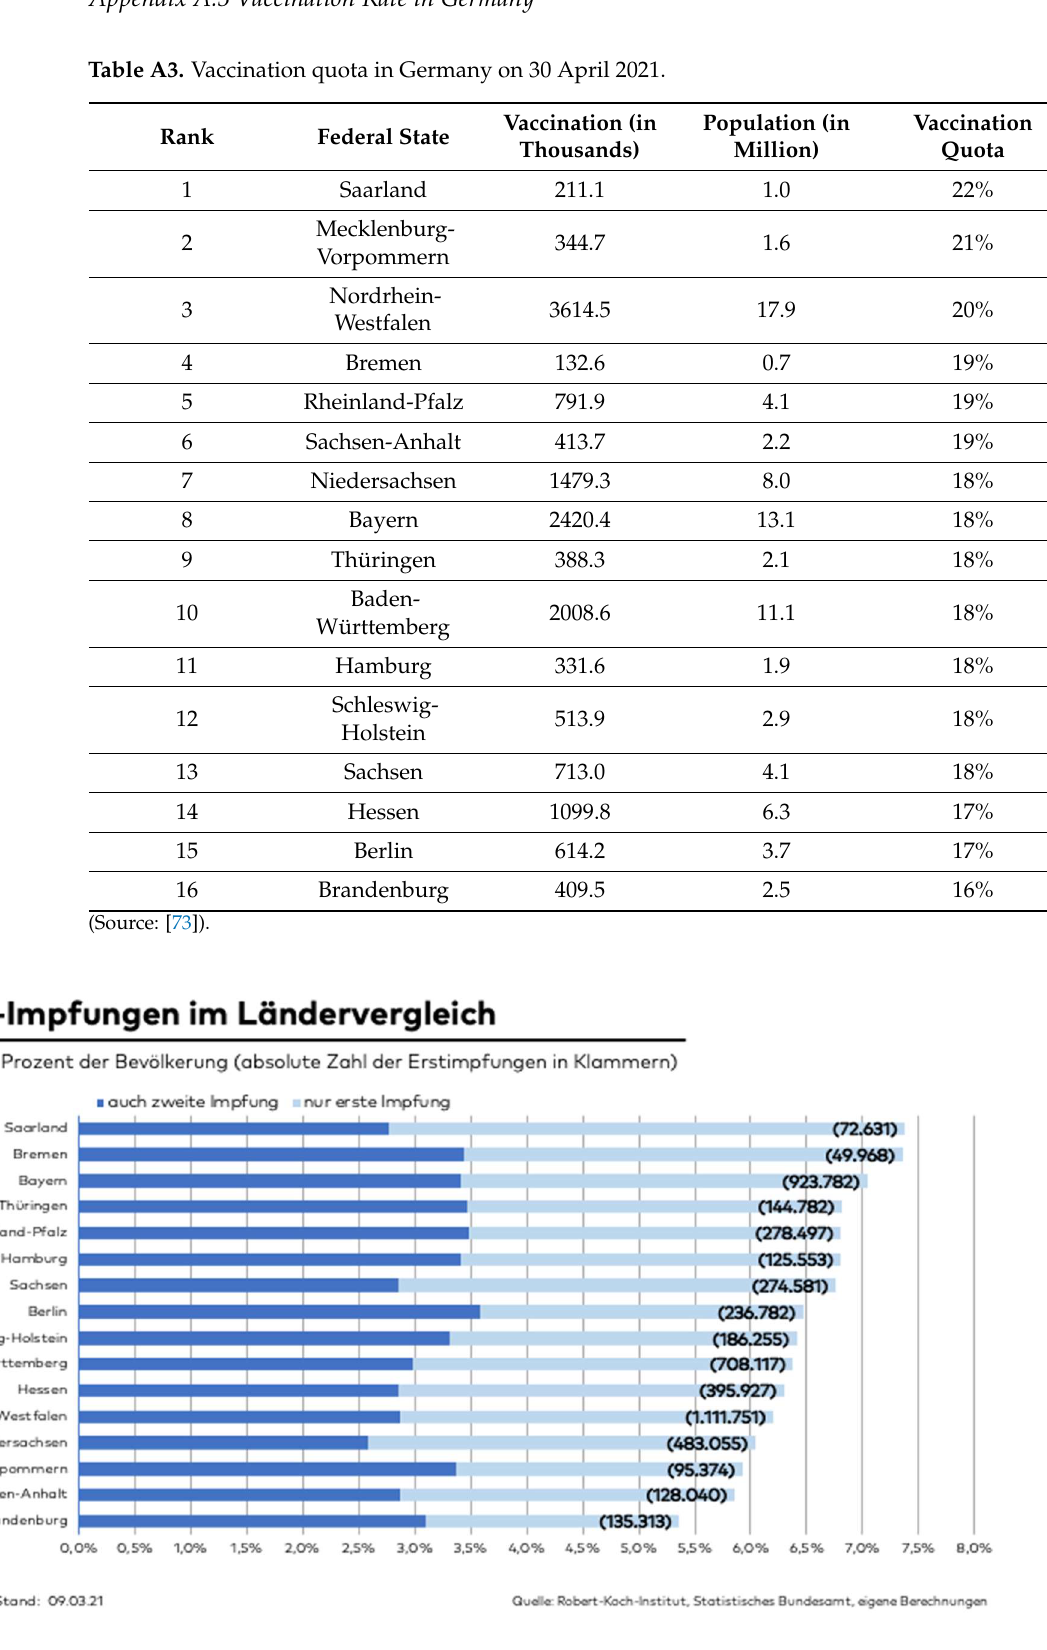
Figure A1. German newspaper “Welt” on vaccination rate of 16 federal states.